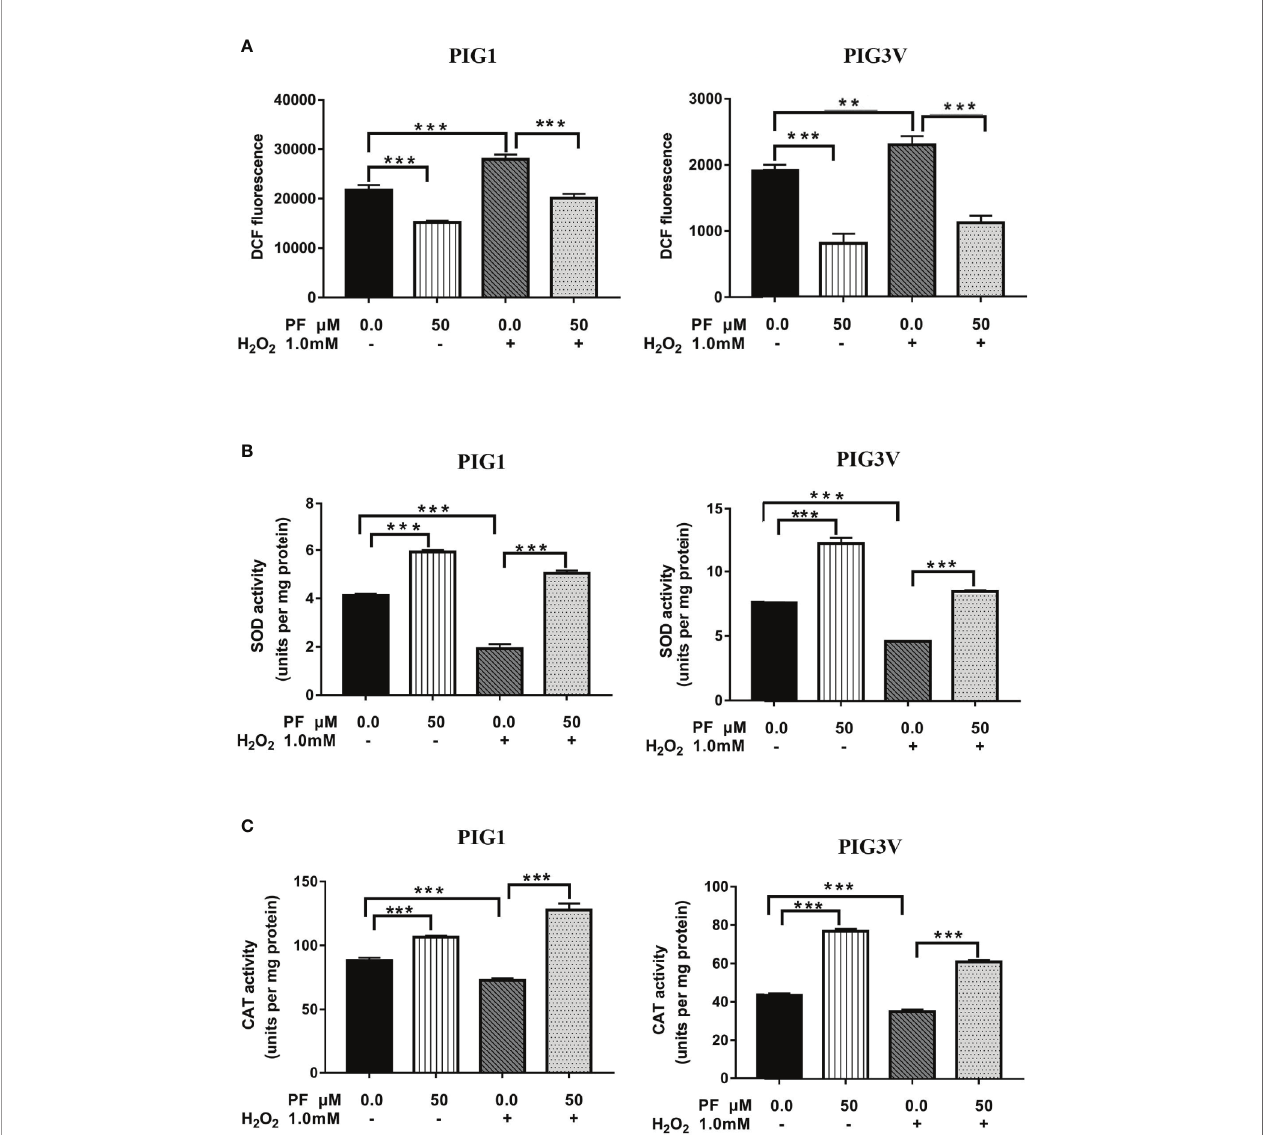
FIGURE 4 | PF attenuates H 2 O 2 -induced oxidative stress in melanocytes. Melanocytes were pretreated with PF for 24 h and exposed to 1.0 mM H 2 O 2 for another 24 h. (A) The ROS production were analyzed by the fl ow cytometry. The activities of antioxidant enzymes SOD (B) and CAT (C) were respectively detected with Catalase Assay kit and Total Superoxide Dismutase Assay kit with WST-8 assay. All data were presented as the mean ± standard deviation across three independent experiments. ** P < 0.01, *** P < 0.001. ns, not signi fi cant; ROS, reactive oxygen species; SOD, superoxide dismutase; CAT, catalase; H 2 O 2 , hydrogen peroxide; PF, Paeoni fl orin; h, hours; M,